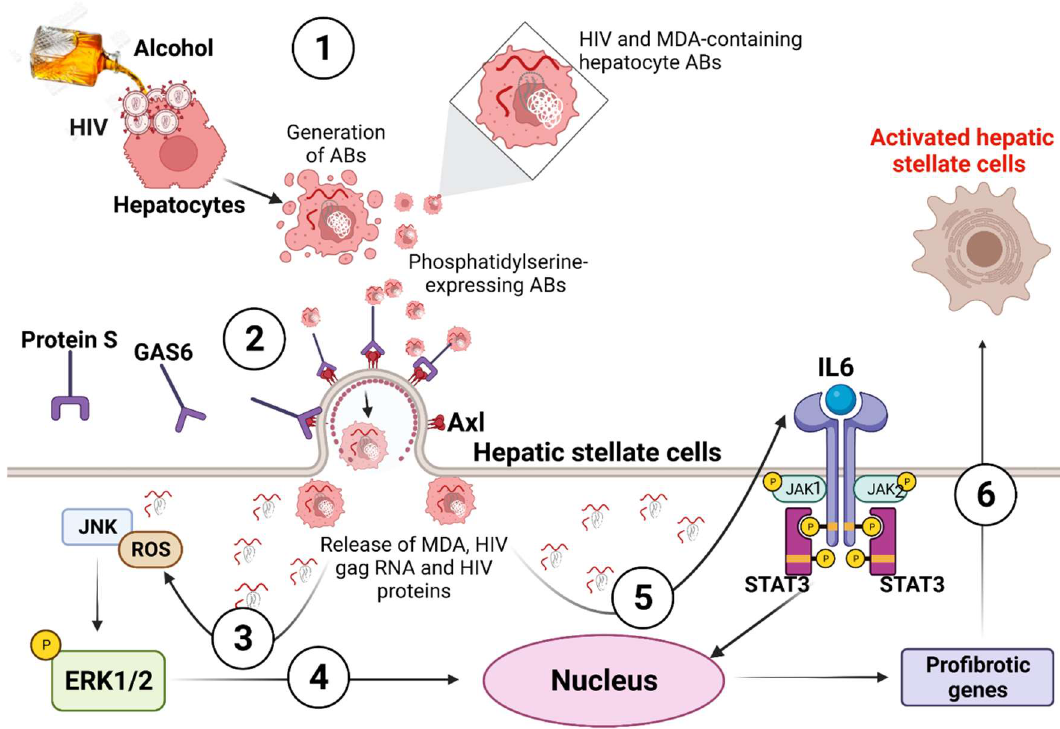
Figure 12. HSC internalization of ABs generated from alcohol- and HIV-exposed hepatocytes induced ROS and IL6-mediated HSC activation. The mechanistic steps include: 1. Both the alcohol metabolite, acetaldehyde, and HIV trigger hepatocyte apoptosis. This leads to the generation of HIV and MDA-containing hepatocyte ABs which express PtylS. 2. HSC internalizes HIV and MDA-containing ABs through Axl, a PtylSRR, with the help of the two bridging molecules, Gas 6 and protein S. 3. The release of HIV proteins, HIV gag RNA and MDA into HSC by internalized ABs triggers intracellular ROS generation. This ROS mediates JNK activation, which leads to the phosphorylation of the ERK1/2 pathway. 4. Nuclear translocation of phosphorylated ERK1/2 induced the biosynthesis of profibrotic genes. 5. The delivery of HIV and MDA into HSC by internalized ABs induced IL-6 synthesis required to activate the JAK-STAT3 pathway. The activated STAT3 leads to the biosynthesis of profibrotic genes. 6. Activation of profibrotic genes in HSC promotes liver fibrosis development.